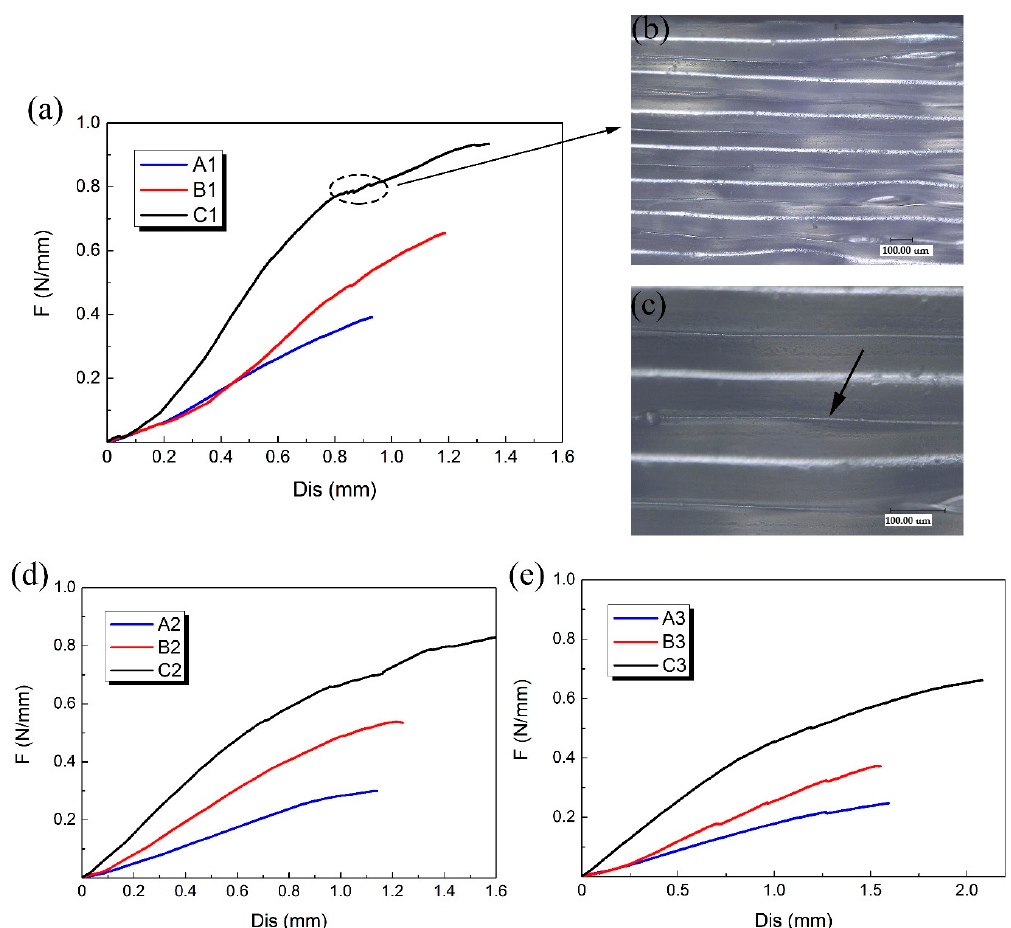
Figure 8. Radial force (per unit length) versus radial displacement curves for different wall thickness of 3D-printed PLA vascular stents and the digital microscope images of stent surface, ( a ) PLA vascular stents with 12 mm stent diameter; ( b ) Digital microscope image of PLA stent surface magnified 200 times; ( c ) Digital microscope image of PLA stent surface magnified 500 times; ( d ) PLA vascular stents with 15 mm stent diameter; ( e ) PLA vascular stents with 18 mm stent diameter. The B, D and E groups of 3D-printed PLA vascular stents had the same wall thickness, but